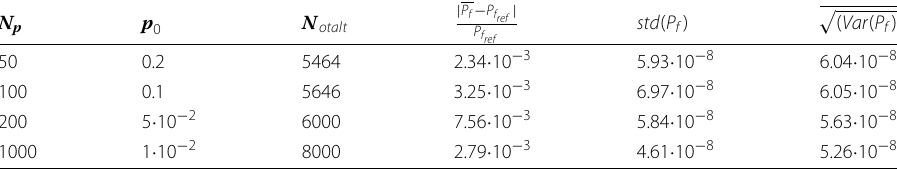
Table 3 1D truss: influence of the adaptive parameters N p and p 0 using the same relation ( N p · p 0 = 10 ) in the adaptive design point estimation using the analytic limit state function (50 runs with N = 5000 ) (cid:16) | P f − P fref | N p p N std ( P f ) ( Var ( P f ) otalt 0 P fref 50 0.2